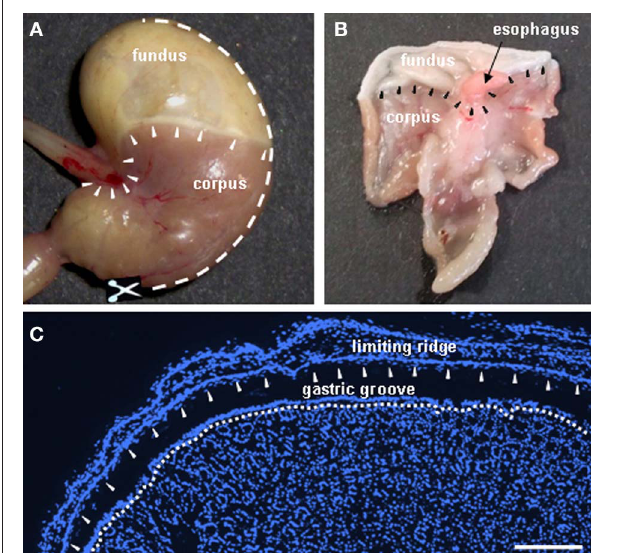
FIGURE 1 | Anatomy of the murine stomach: sections were made through the gastric mucosa encompassing the “limiting ridge” which covers the adjoining corporal mucosa. (A) Digital photograph showing a view onto the mouse stomach. Arrowheads display the course of the “limiting ridge” around the esophagal orifice and along the boundary between fundus and corpus. The white broken line denotes sectioning; to open the stomach, the bottom of the greater curvature was dissected along the greater curvature to the fundic compartment (B) . After opening the stomach along the greater curvature, the gastric mucosa was embedded flatly as demonstrated in the digital photograph and sections were made from the luminal side of the gastric mucosa, resulting in cross sectioned mucosal glands and the prolonged arrangement of the “limiting ridge” accompanying the corpus tissue in a small distance (C) . Arrowheads depict the course of the “limiting ridge.” (C) Cryosection demonstrating the fundus/corpus boundary of the gastric mucosa. The “limiting ridge,” denoted by the arrowheads appears as a tissue strip covering the underlying apical corpus mucosa which forms the distal wall of the “gastric groove.” The white broken line depicts the most apical cell layer of the corpus mucosa facing the lumen of the “gastric groove.” Sections were counterstained with DAPI ( blue ). Scale bar: (C) = 200 μ